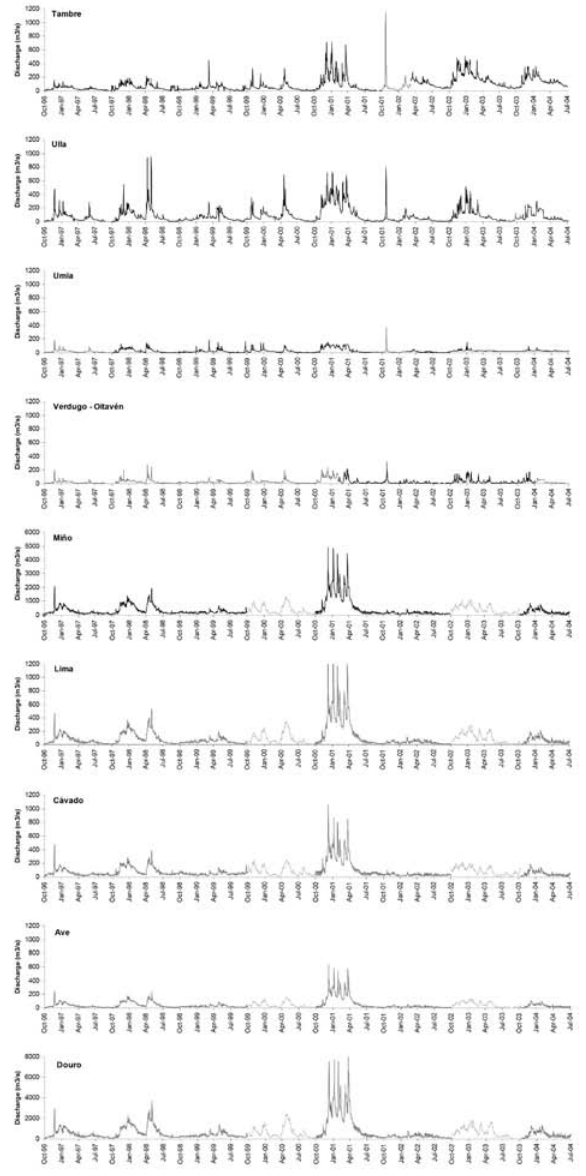
Fig . 7. – Reconstruction of the entire set of rivers based on a high correlated river basin in terms of runoff (thick gray line) and on pre- cipitation rate (thin gray line) from October 1996 to August 2004. Direct estimations of river discharge at the mouth of the rivers from available gauge records (black line) are also shown.